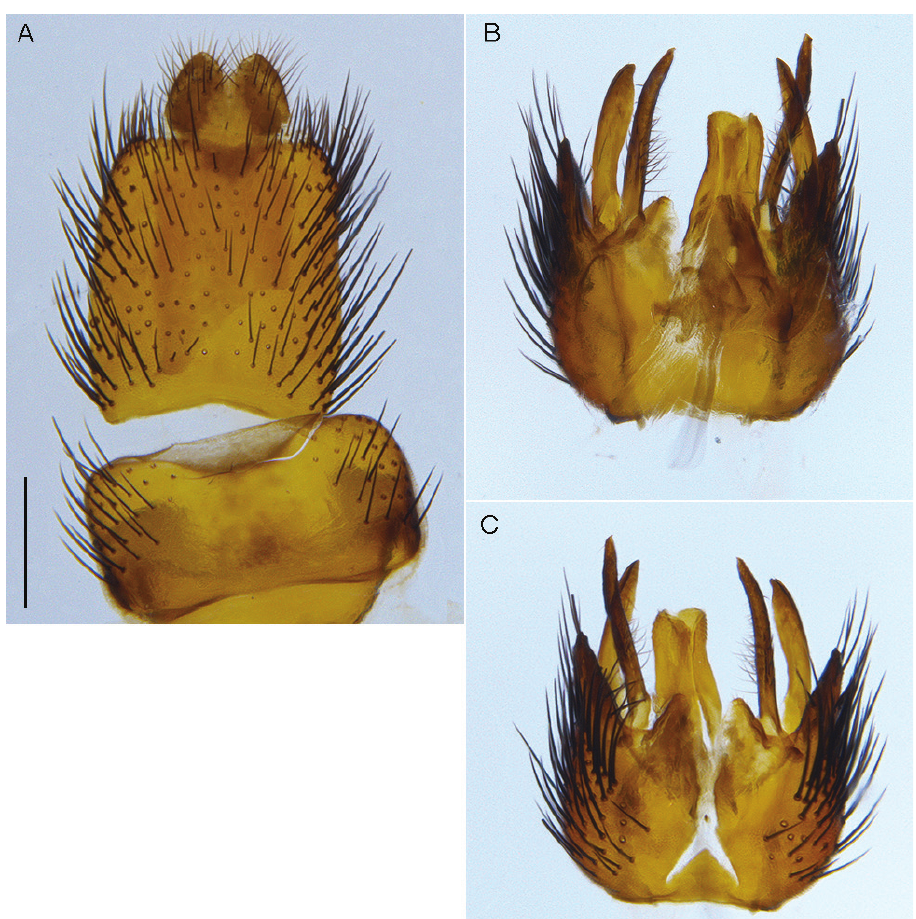
Figure 6. Sidarena aurantia sp. n., male genitalia: A Epandrium and tergite 8, dorsal view B Gonocoxites and aedeagus, dorsal view (epandrium removed) C same, ventral view. Scale line: 0.2 mm.